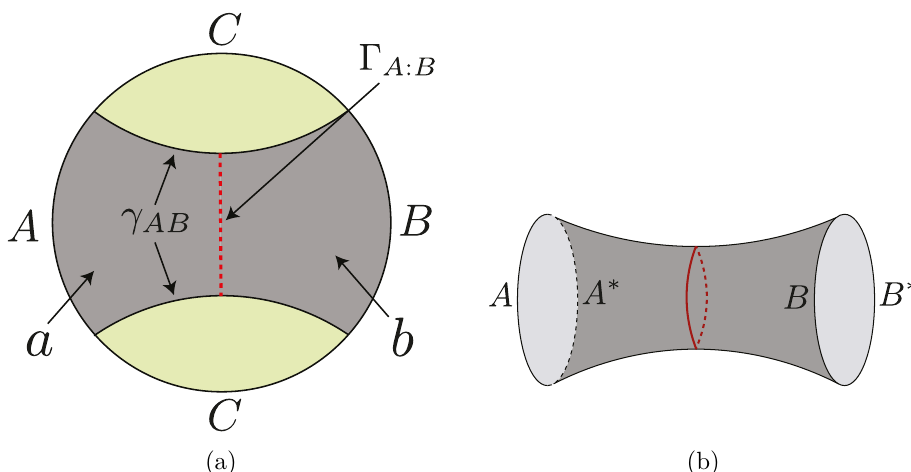
Figure 1 . (a) A spatial slice of AdS with A and B chosen to be two intervals. The figure depicts the entanglement wedge of AB (gray), the entanglement wedge of C (green), the RT surface γ and the entanglement wedge cross section Γ . (b) A spatial slice of the proposed holographic A : B |√ dual to the canonically purified state ρ AB i . The RT surface for A ∪ A ∗ is given by a doubled copy of the entanglement wedge cross